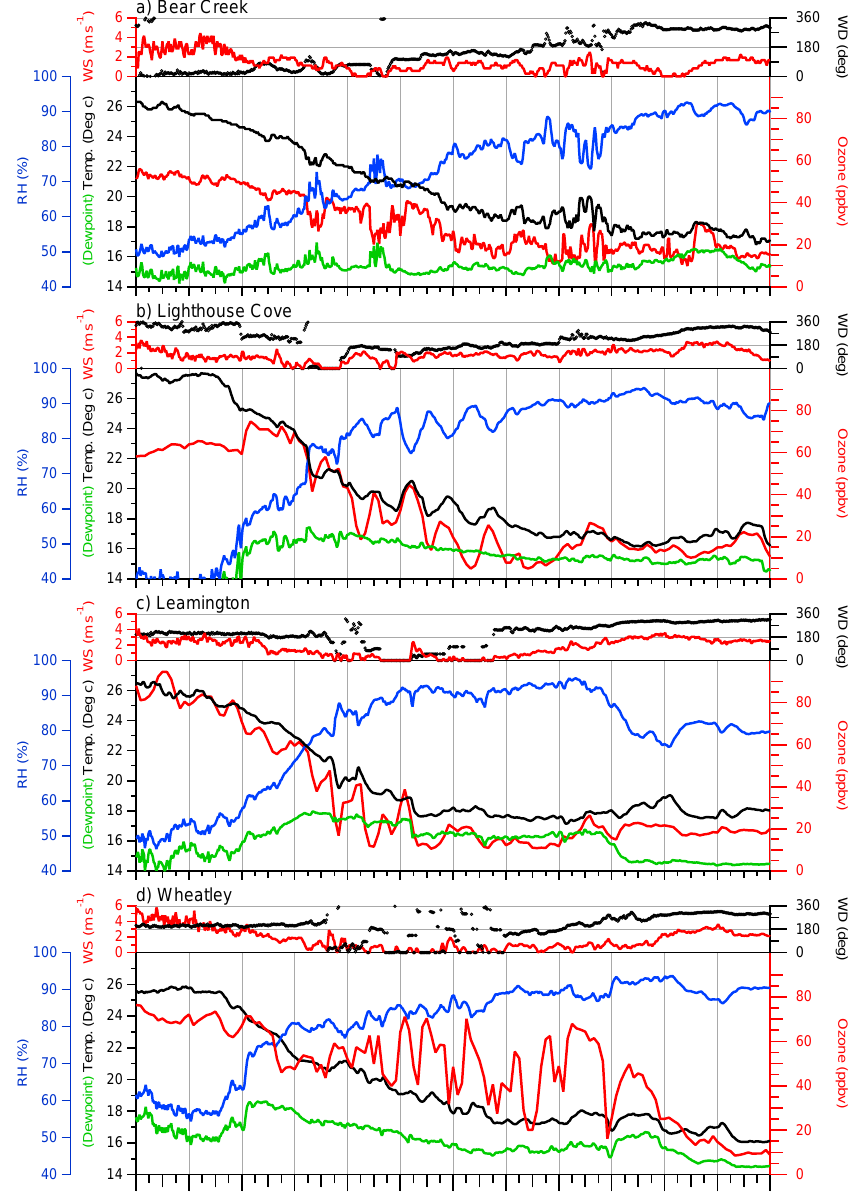
Fig. 12. Meteorological (wind speed (red) and direction (black), temperature (black), dewpoint temperature (green), and relative humidity (blue)) and ozone (red) measurements during the night of 6–7 July, 2007 at four ground stations ( a – Bear Creek, b – Lighthouse Cove, c – Leamington and d –